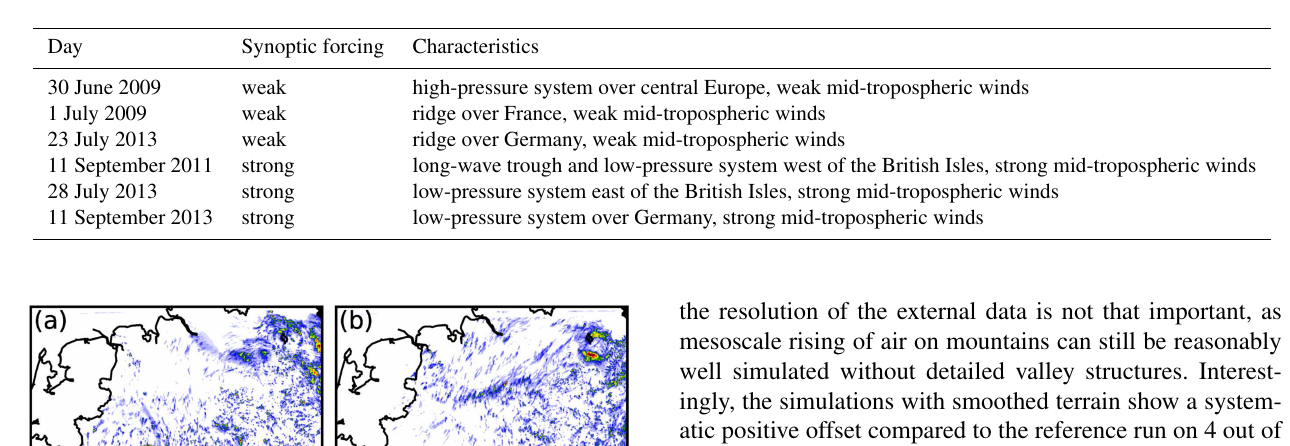
Table 2. Investigated cases.